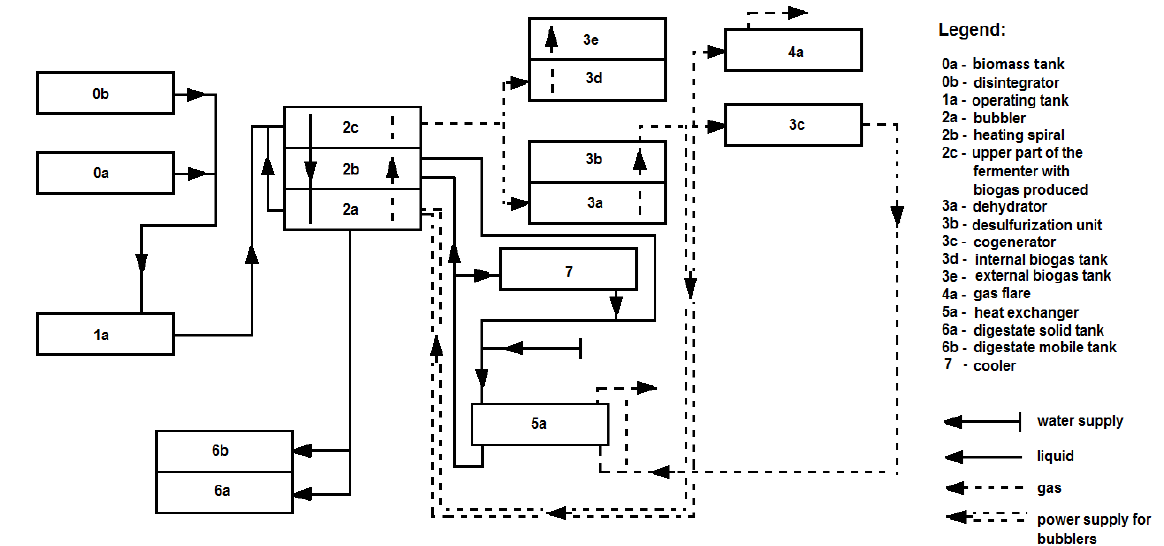
Figure 3. Diagram of a test bench for the production and purification of raw agricultural biogas [own elaboration].